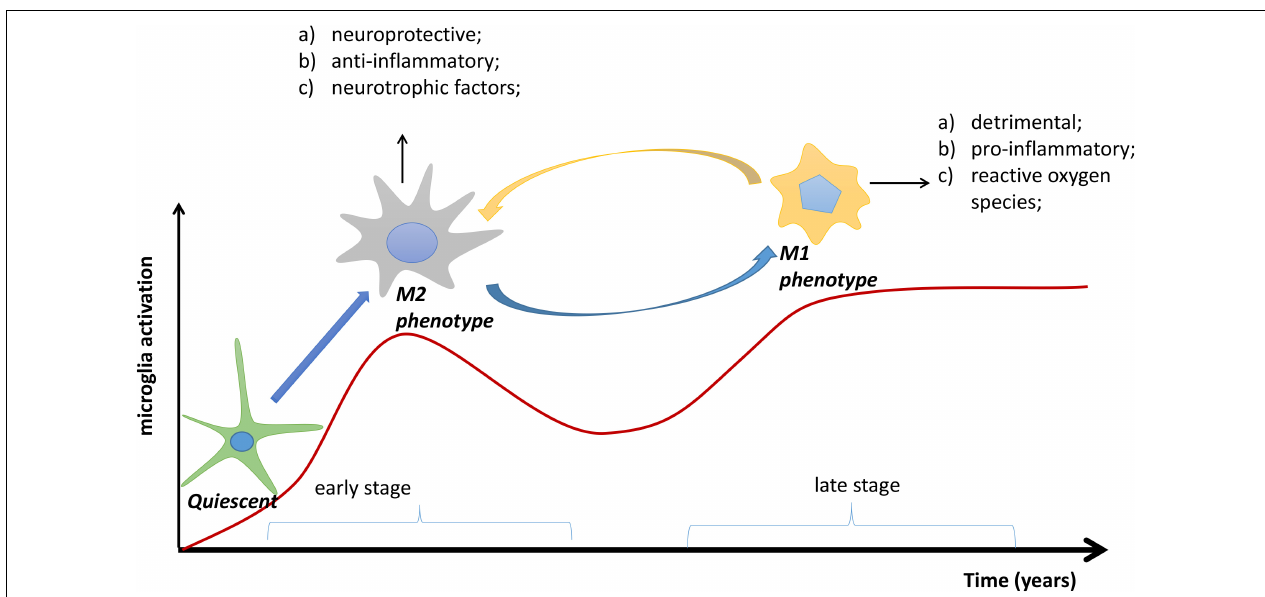
FIGURE 1 | The transformation process of microglial phenotypes in Alzheimer’s disease (AD). In the early stage of AD, quiescent microglias are activated to the M2 phenotype by accumulating A β plaques; in the later stage, the M2 phenotype may be transformed to the M1 phenotype. Overall, the M2 phenotype is neuroprotective and anti-inflammatory, whereas the M1 phenotype is detrimental and pro-inflammatory. Red line: degree of microglial